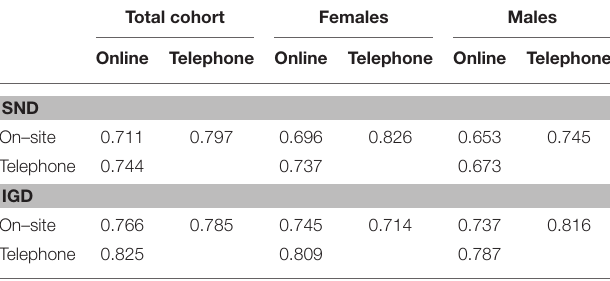
TABLE 4 | Spearman correlations ( ρ ) between different assessment sites. Total cohort Females